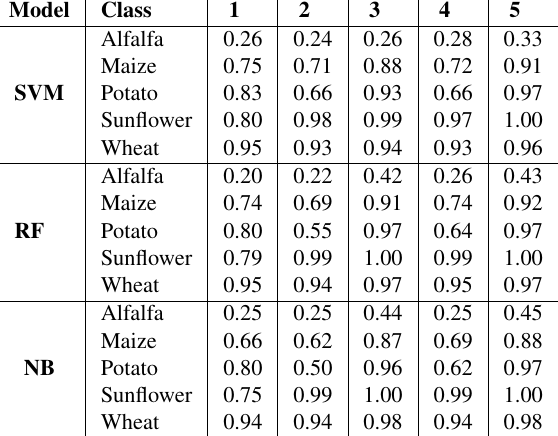
Table 6. Class accuracies via F-1